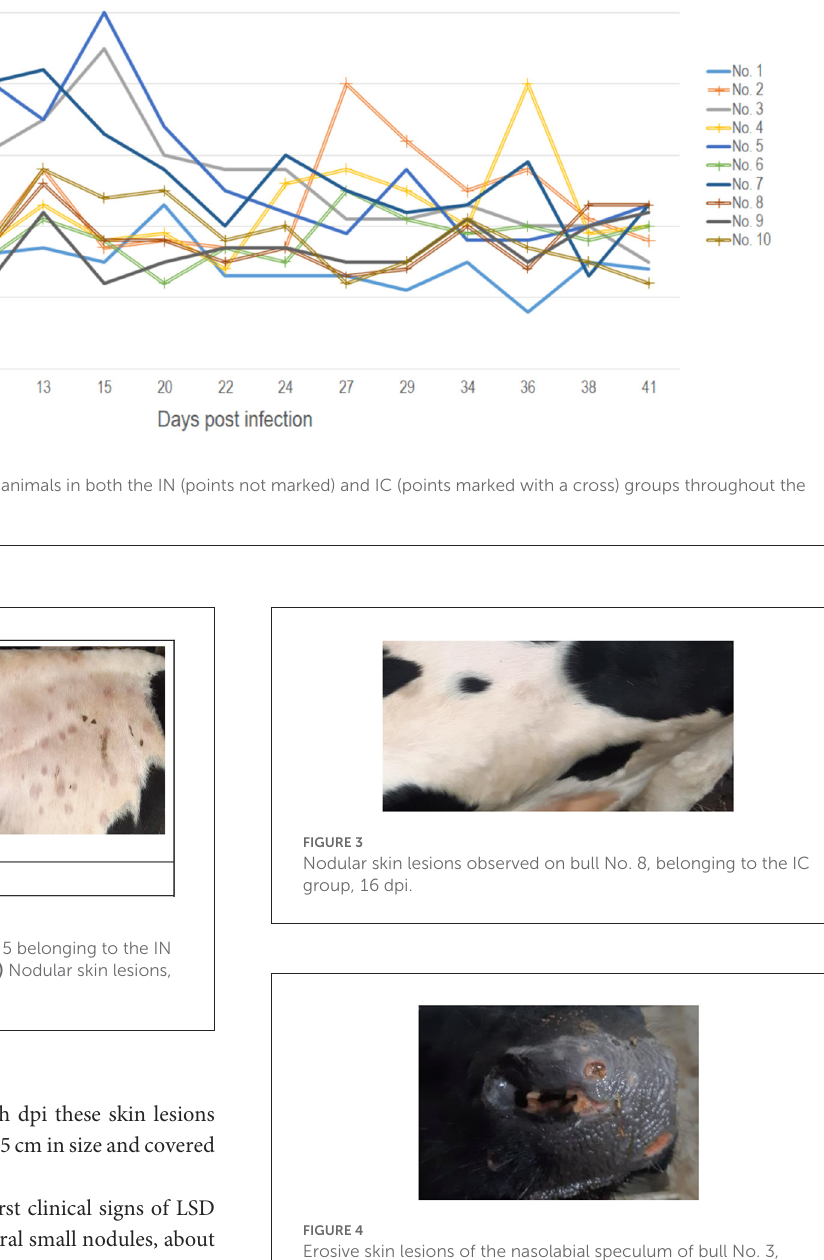
Clinical manifestations of LSD were observed in four of the five uninfected (IC) animals on day 26 of the experiment. Bulls No.2, No.4, and No.6 displayed severe symptoms including nodular lesions on their backs, heads, fore and hind limbs, scrotum, erosive lesions on the nasolabial mirror,